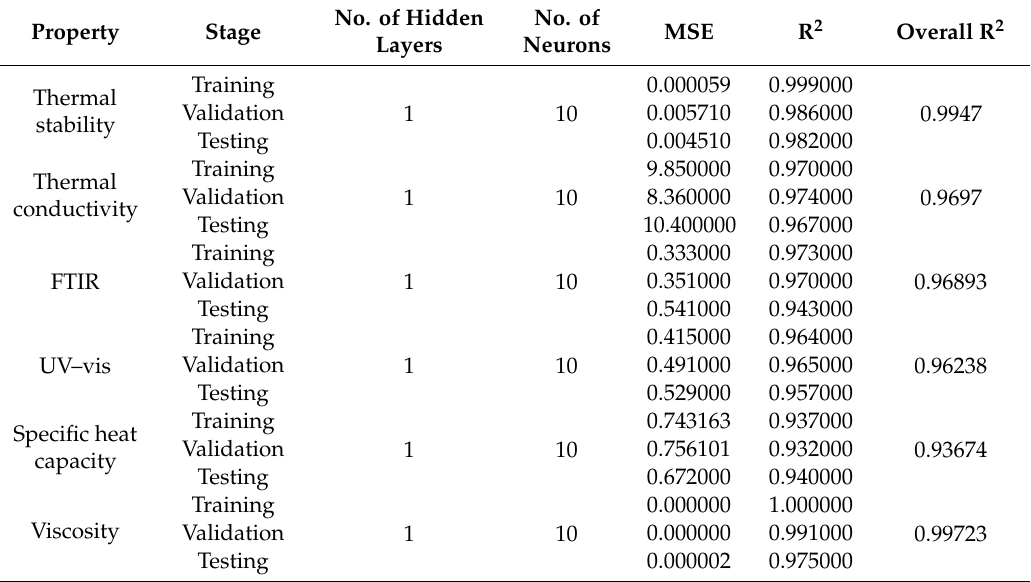
Table 1. MSE and R 2 values of the studied